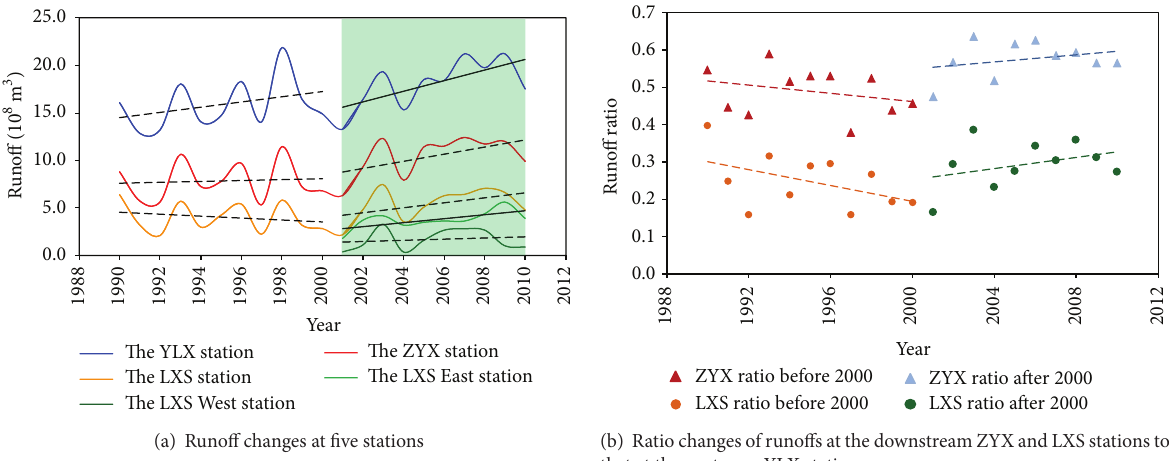
Figure 8: Runoff variation in the Heihe River Basin before and after NTECP. ∗ Regression that is significant ( 𝑃 ≤ 0.05 ) or nonsignificant ( 𝑃 > 0.05 ) is presented with solid line or dashed line,